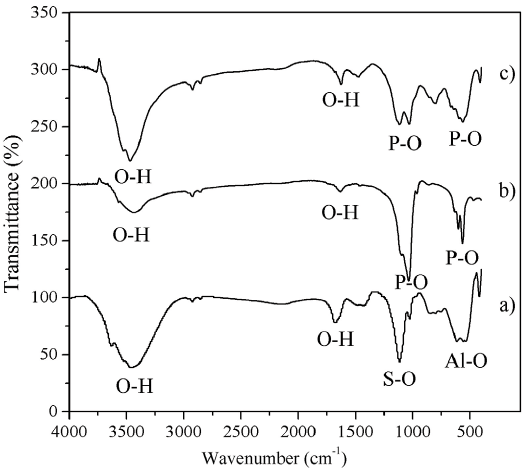
Figure 4. FT-IR spectra of (a) CSAC hydrated in water for 21 days, (b) stoichiometric hydroxyapatite and (c) CSAC after immersion in SBF for 21 days.